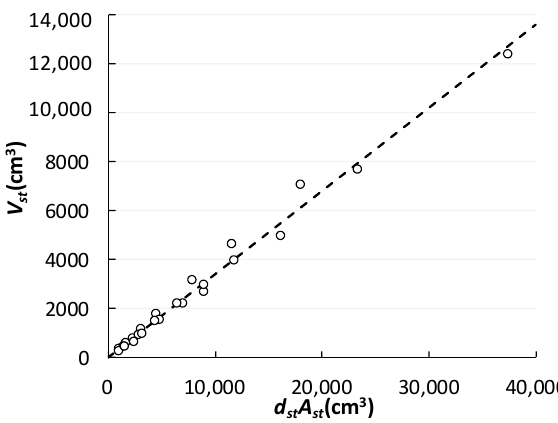
Figure 5. Ratio between V st and d st A st .